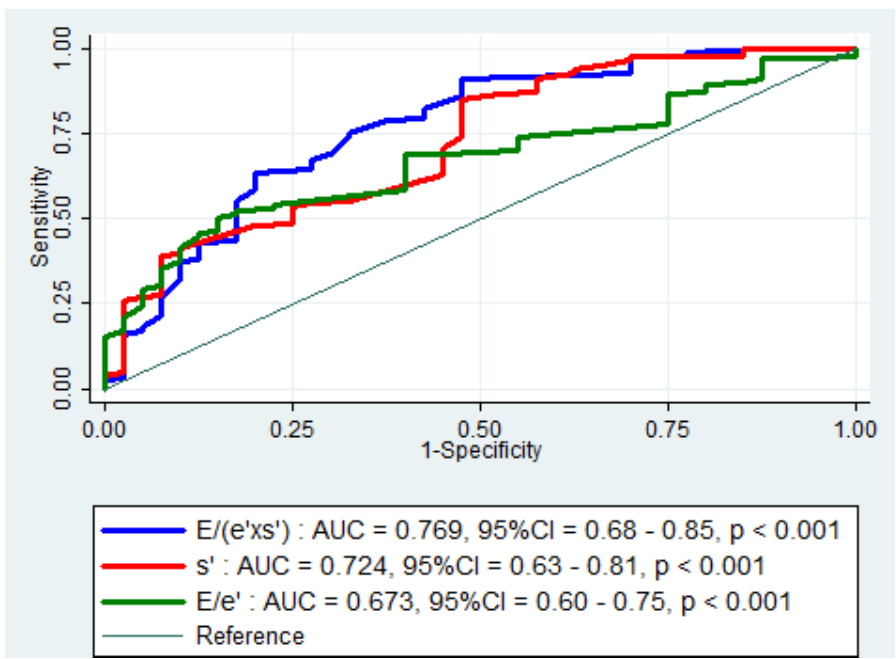
Figure 1. Receiver operating characteristic (ROC) curves for E/(e’×s’), E/e’ ratio, and s’ velocity to predict cardiac events in patients with non-ST-segment elevated acute coronary syndrome. AUC = area under the ROC curve; CI = confidence interval; E = peak early diastolic transmitral velocity; e’ = peak early diastolic mitral annular velocity; s’ = peak systolic mitral annular velocity. Table 2. Echocardiographic variables at hospital discharge associated with composite endpoints (hospital readmission or cardiac death) in Cox univariate and multivariate analysis.